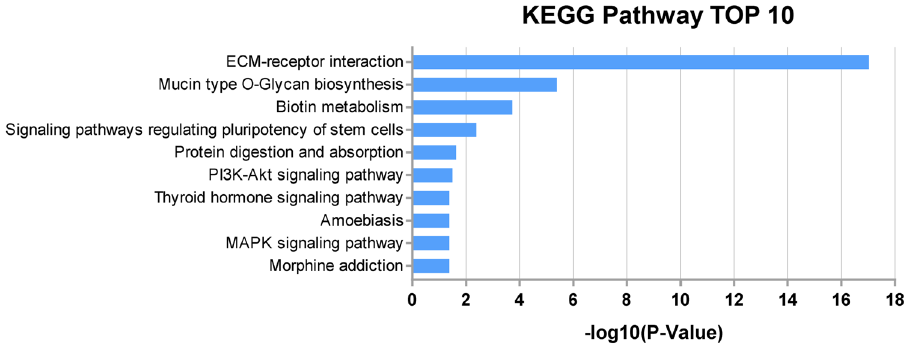
Figure 4. KEGG pathway. Enrichment score was represented as − log10 ( p -value). The higher the enrichment score value is, the more significant the pathway is. The KEGG pathways relating to ECM-receptor interaction (hsa04512; 17.03), mucin-type O-glycan biosynthesis (hsa00512; 5.40), biotin metabolism (hsa00780; 3.73) and signaling pathways regulating pluripotency of stem cells (hsa04550; 2.39) were significantly associated with miRNAs increased in the aqueous humor of NTG patients. Note that the pathway relating to ECM-receptor interaction showed the most significant association with up-regulated miRNAs in NTG patients compared to other pathways. Data was analyzed by DianaTools. KEGG Kyoto Encyclopedia Genes and Genomes, ECM extracellular matrix.